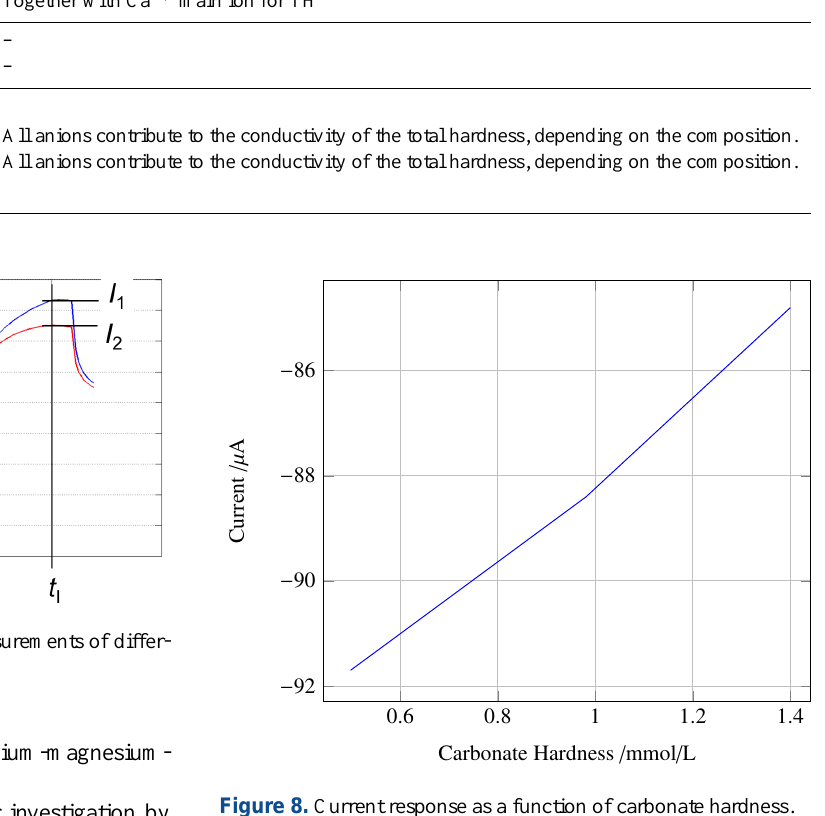
Figure 7. Two typical cyclic voltammetry measurements of di ff er- ent water samples.